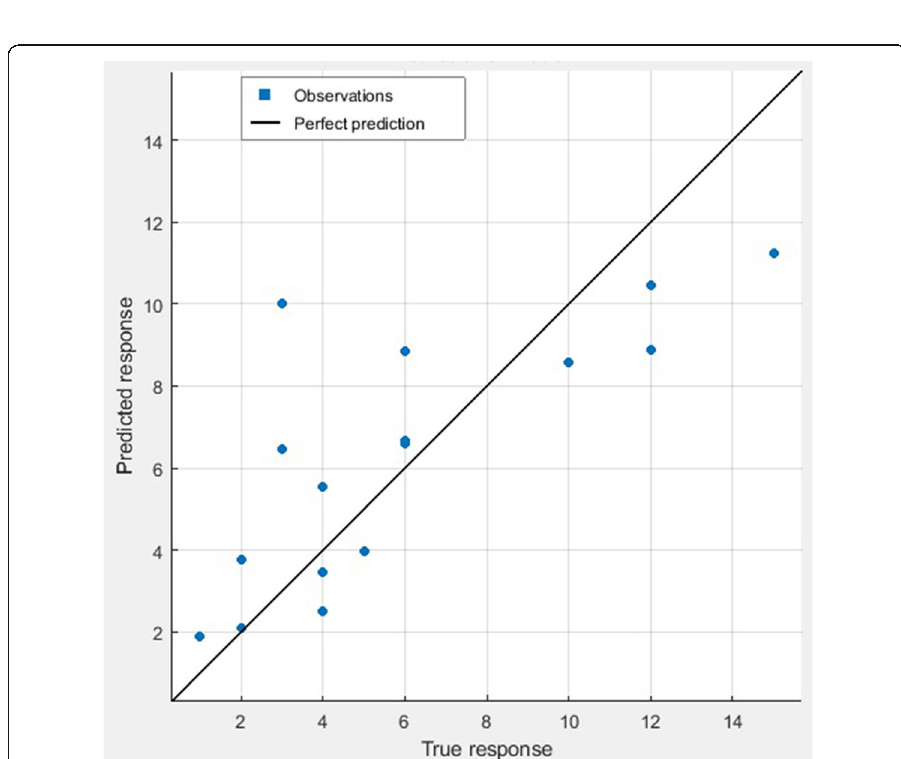
Fig. 1 Actual observations vs. predicted by